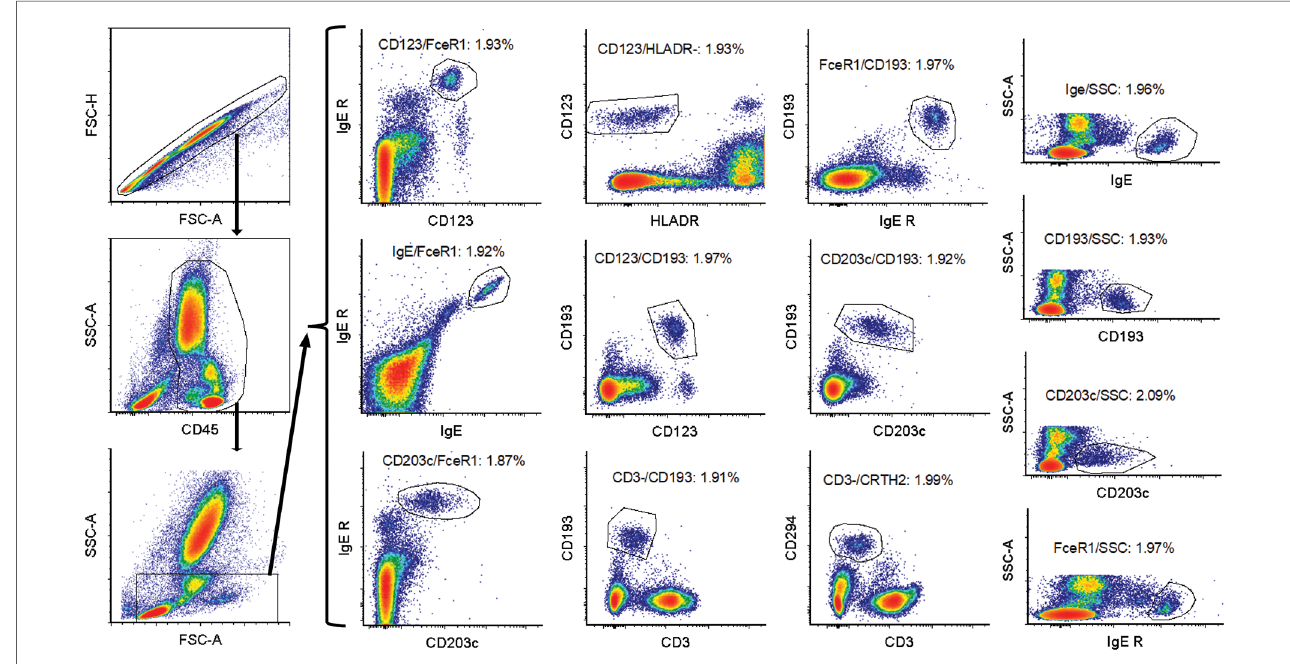
FIGURE 1 Gating strategy for basophil identi fi cation. First an FSC-A/FSC-H gate was used to gate on singlets. Subsequently a CD45/SSC gate was drawn around the white blood cells. This was followed by an FSC-SSC gate to gate out some non-basophils. The basophils were then identi fi ed using 13 different gating strategies: CD123/CD193, IgE/Fc ε RI, HLADR/CD123, CD203c/Fc ε RI, Fc ε RI/CD193, CD3/CD294, CD3/CD193, Fc ε RI/CD193 and CD123/Fc ε RI, IgE/SSC, Fc ε RI/SSC, CD193/SSC, and CD203c/SSC.